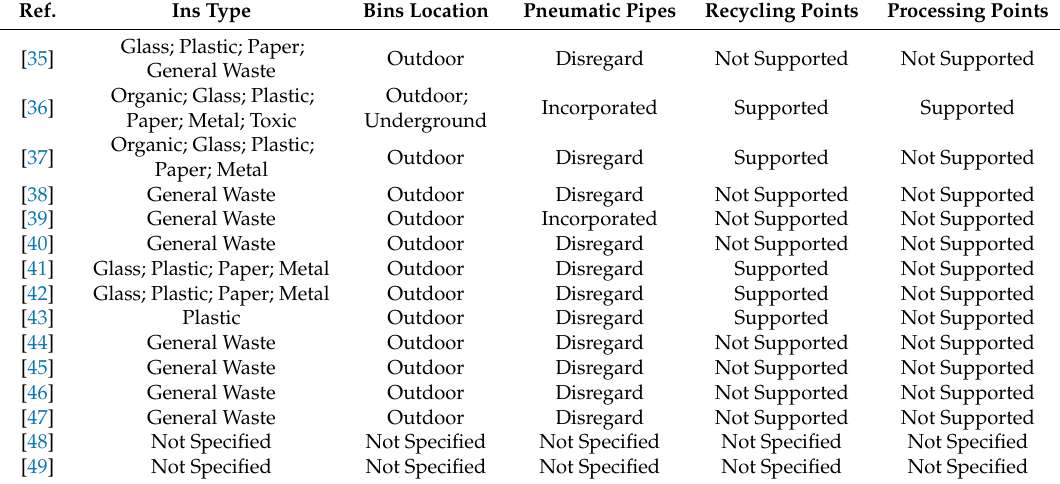
Table 1. Physical infrastructure comparison considering the most relevant solutions available in the literature.